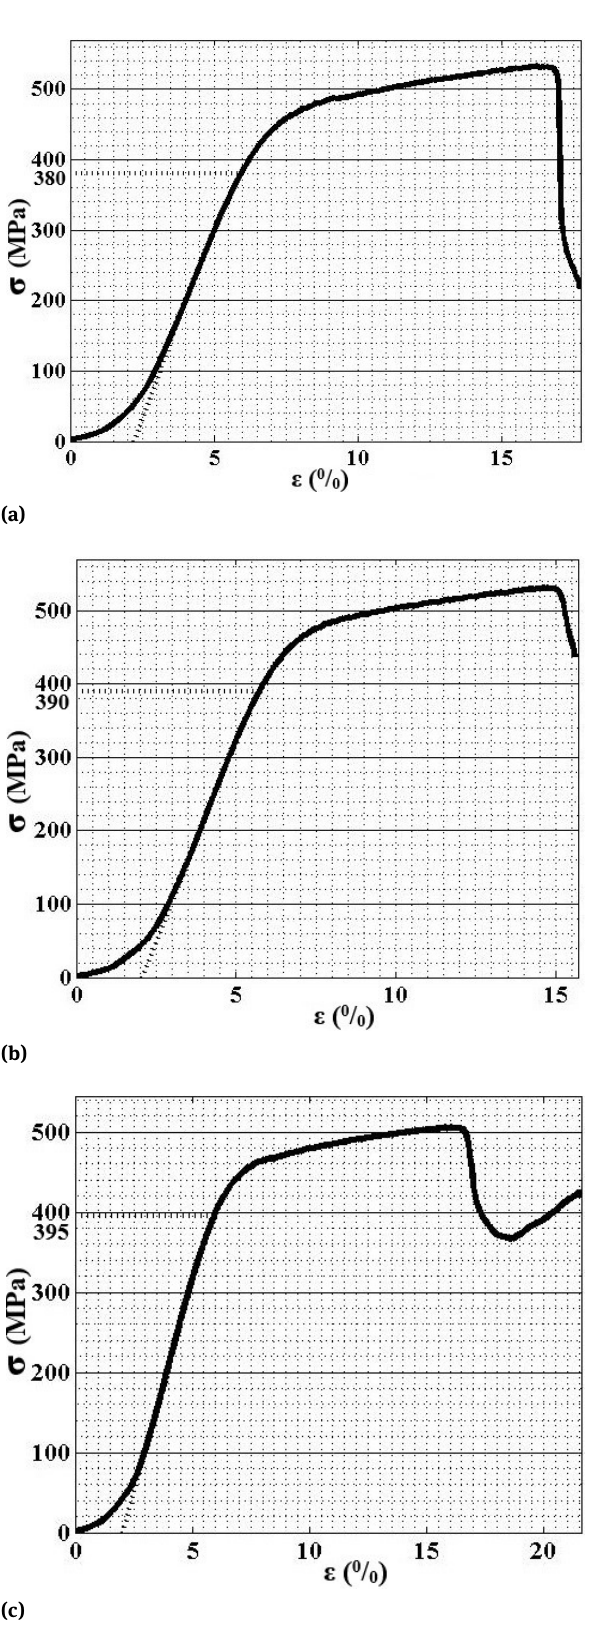
Figure 8: Corresponding stress-strain curves of Al-Al 2 Cu FGM from compressive test at different section (a) 0-4 mm, (b) 4-8 mm, (c) 8-12 mm, away from inner wall of the